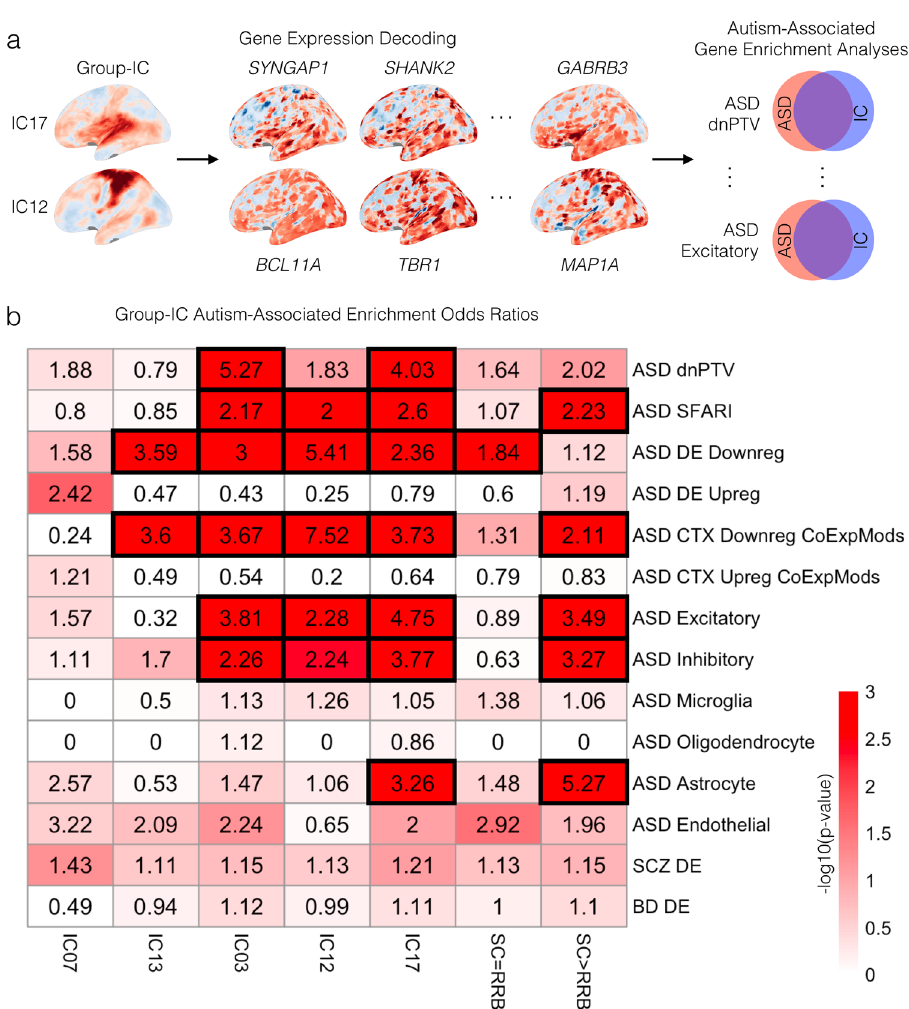
Fig. 4 Overlap between genes expressed in functional connectivity networks and genes linked to autism. In panel ( a ) we depict the analysis approach of identifying genes that are highly expressed in similar spatial patterns to the rsfMRI spatial IC maps (i.e., gene expression decoding). Once IC gene lists have been identi fi ed, we test these lists for enrichment with known lists of autism-associated functional genomic mechanisms (top left). In panel ( b ) we show enrichment odds ratios (numbers in each cell) along with the − log10 p value (coloring of the cells) for enrichment tests of speci fi c networks (columns) against known lists of autism-associated genomic mechanisms (rows). Cells outlined with thick black rectangles survive FDR q <0.05. The column labeled SC >RRB shows the enrichment results when the gene list under consideration comprises genes unique to IC17, but not any of the other ICs. The column labeled SC = RRB shows the enrichment results when the gene list under consideration consists of genes unique to IC03, IC07, and IC13, but not IC12 or IC17. ASD dnPTV, Autism de novo protein-truncating variants; ASD SFARI, SFARI Gene autism-associated genes; ASD DE Downreg, autism differentially expressed downregulated genes; ASD DE Upreg, autism differentially expressed upregulated genes; ASD CTX Downreg CoExpMods, autism downregulated cortical co-expression modules; ASD CTX Upreg CoExpMods, autism upregulated cortical co-expression modules; ASD Excitatory, autism differentially expressed genes in excitatory neurons; ASD Inhibitory, autism differentially expressed genes in inhibitory neurons; ASD Microglia, autism differentially expressed genes in microglia; ASD Oligodendrocyte, autism differentially expressed genes in oligodendrocytes; ASD Astrocyte, autism differentially expressed genes in astrocytes; ASD Endothelial, autism differentially expressed genes in endothelial cells; SCZ DE, schizophrenia differentially expressed genes; BD DE, bipolar disorder differentially expressed